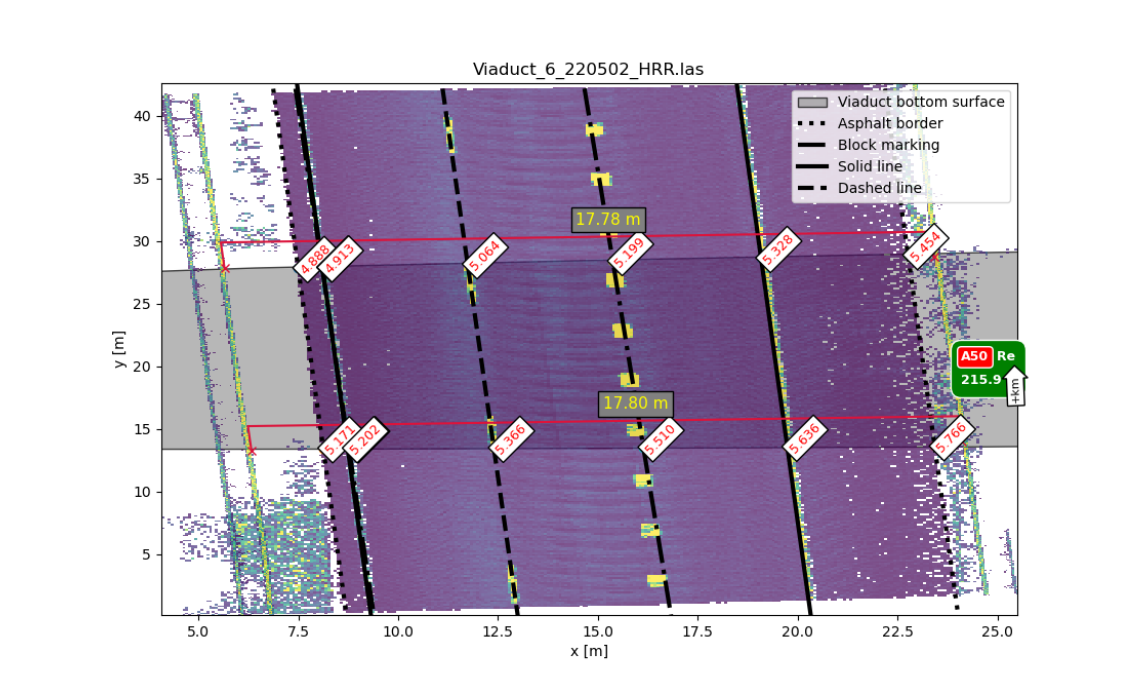
Figure 8. Example of the estimated clearances under a viaduct. The vertical clearances are shown in red and the horizontal clearances in